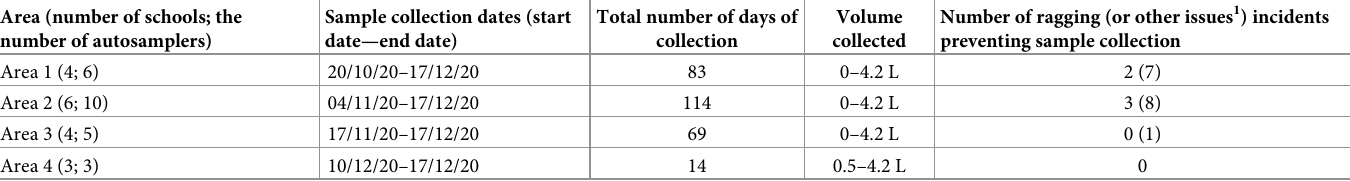
Key: 1 no sample collected for a variety of reasons including ragging (the accumulation of solid wastewater materials greater than 5 mm; number not in brackets) or due to either battery failure, in pipe blockages, autosampler tube out of alignment, unable to access site/inset day or reason not given (summed figure in brackets).